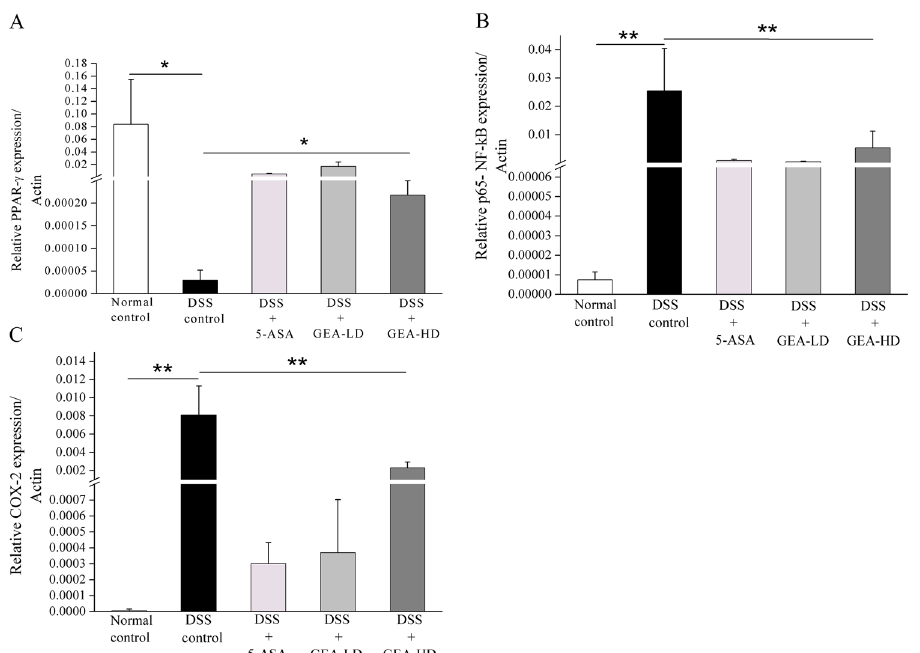
Figure 14. Turkish galls treatment affects the mRNA expression levels of UC-associated targets in mice. After 17 days, the mRNA expression levels of 3 genes were measured by RT-PCR. The relative amount of each gene was expressed using 2 −Δ Ct . The values are expressed as the mean ± S.D. * P < 0.05, ** P < 0.01, *** P <